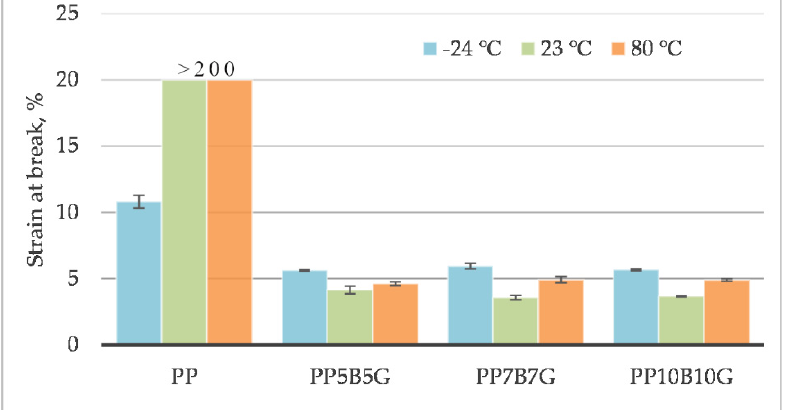
Figure 3. Strain at break of basalt/glass fiber polypropylene composites at − 24 °C, 23 °C, and 80 °C.